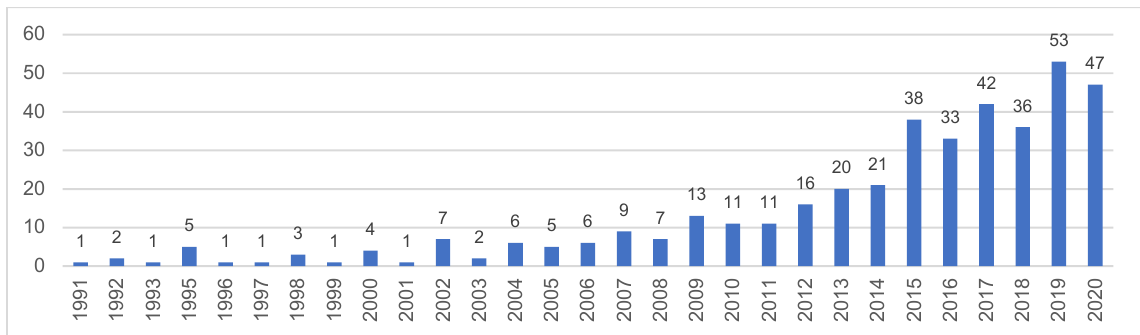
Figure 1. Results of the ISI Web of Science search for ‘Measures of Economic Forecast Accuracy’ in the title of publications for the period 1991–2020. Source: Web of Science database. Table 3. Breakdown by document type of initial contributions to the literature on measures of economic forecast accuracy from 1991 to 2020.